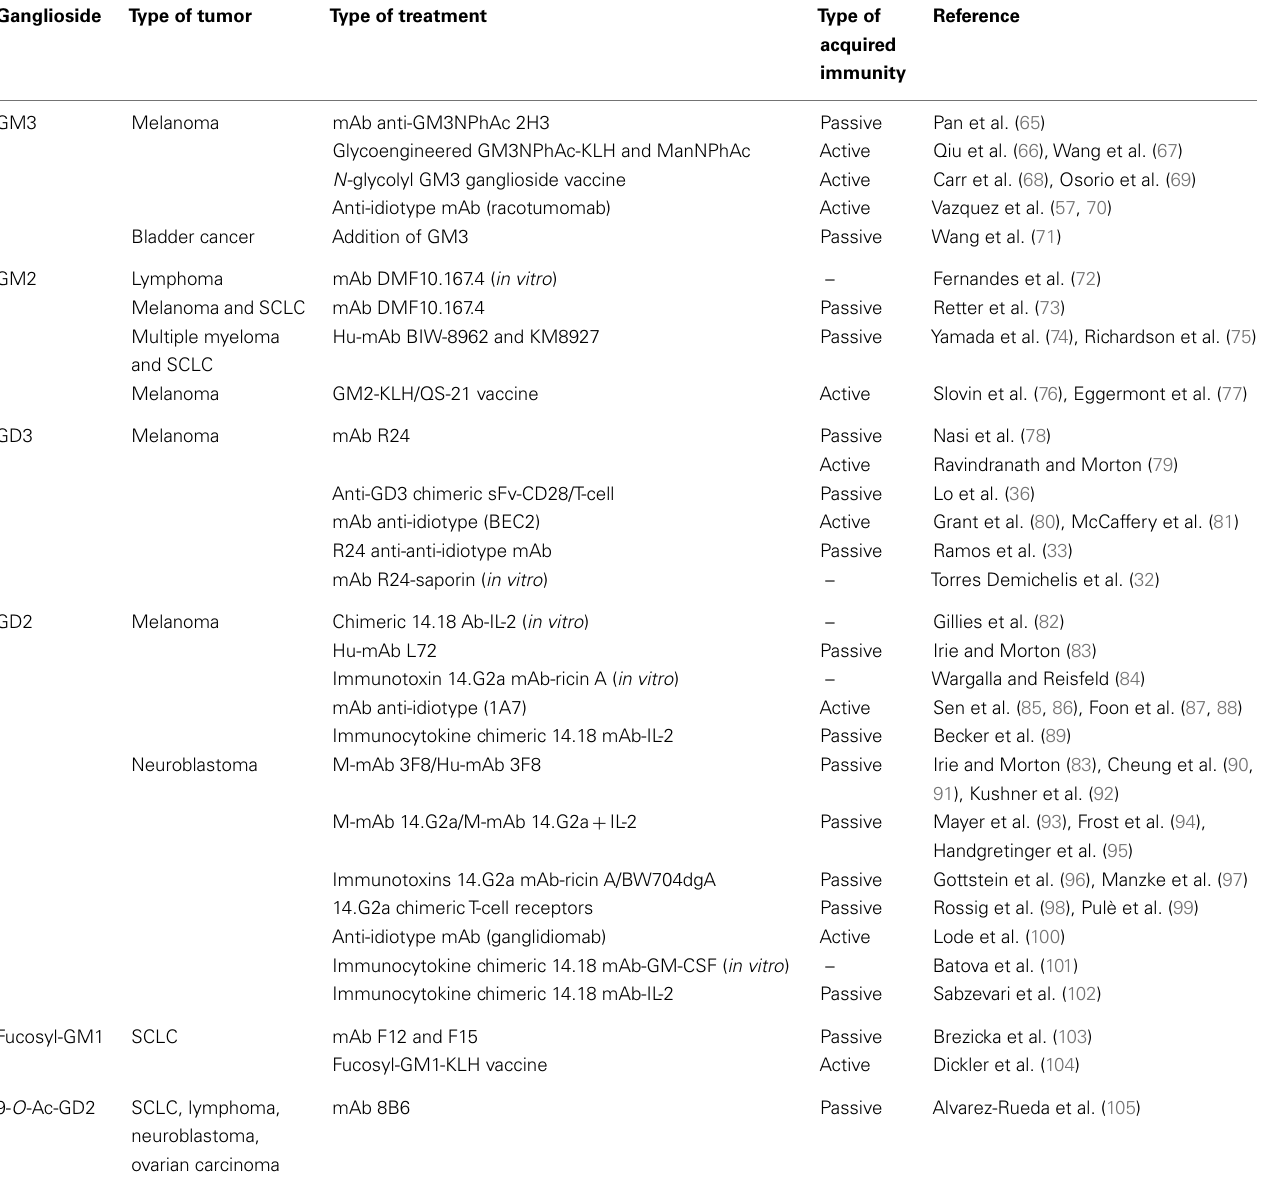
Table 2 | Immunotherapeutic strategies involving tumor associated gangliosides.